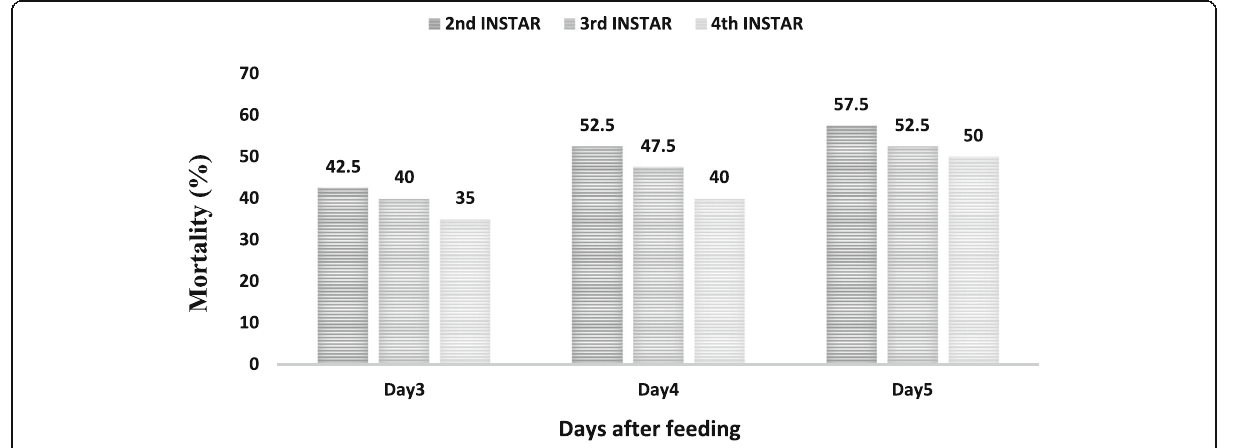
Fig. 3 Mortality of different larval instars of Tuta absoluta caused by 4G1 at LC